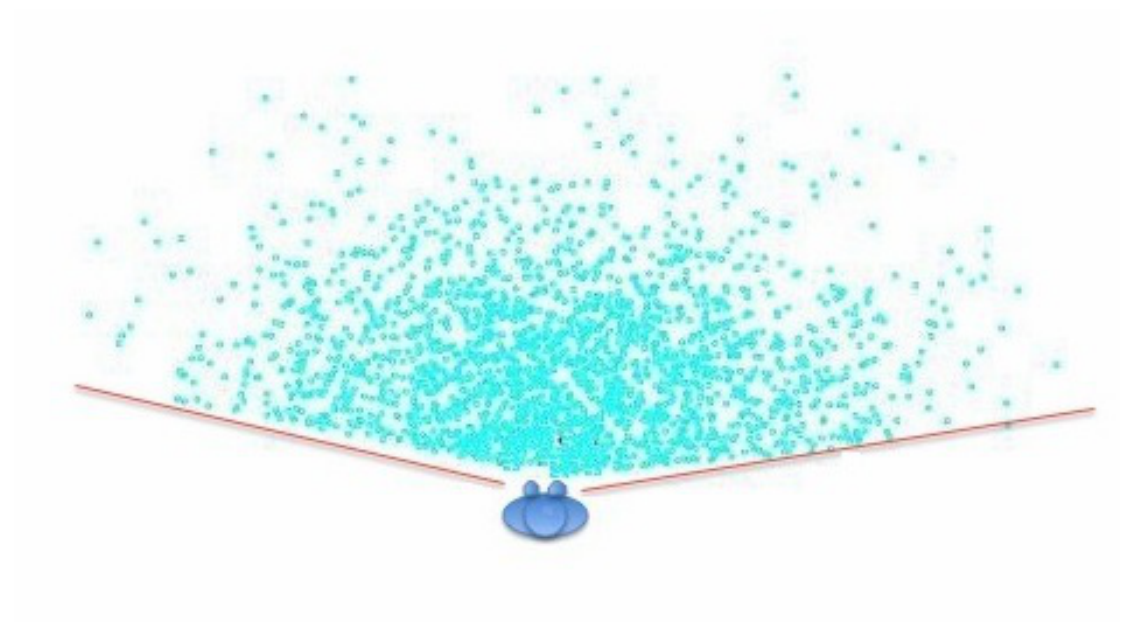
Figure 7. The frustum of a person. The particles (Gaussian samples) are generated to model the frustum of the person in his/her facing